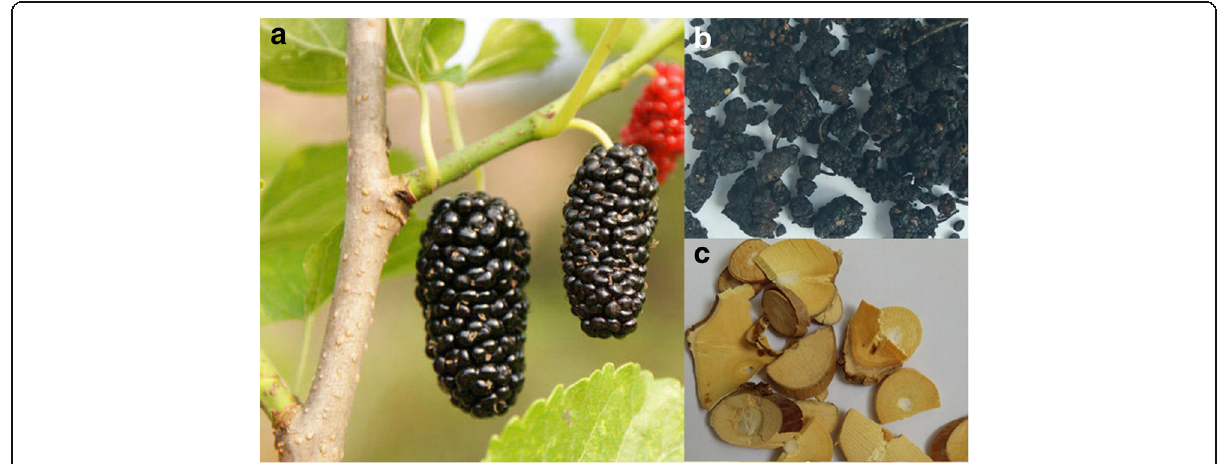
Fig. 1 Images of Morus alba L. ( a ), Mori Fructus ( b ) and Mori Ramulus ( c )